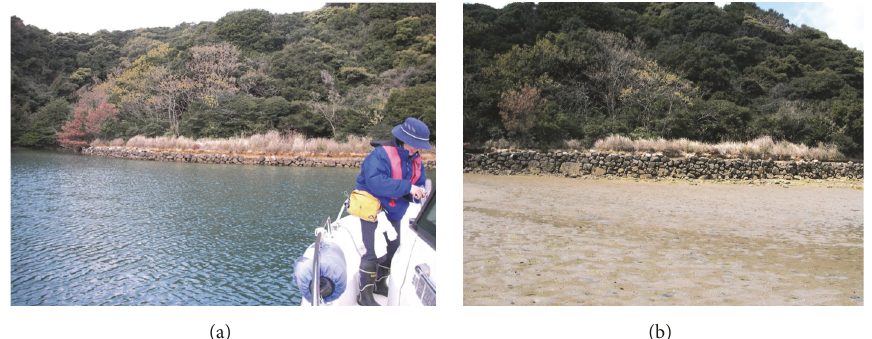
Figure 2: Study site during high tide (a) and during low tide